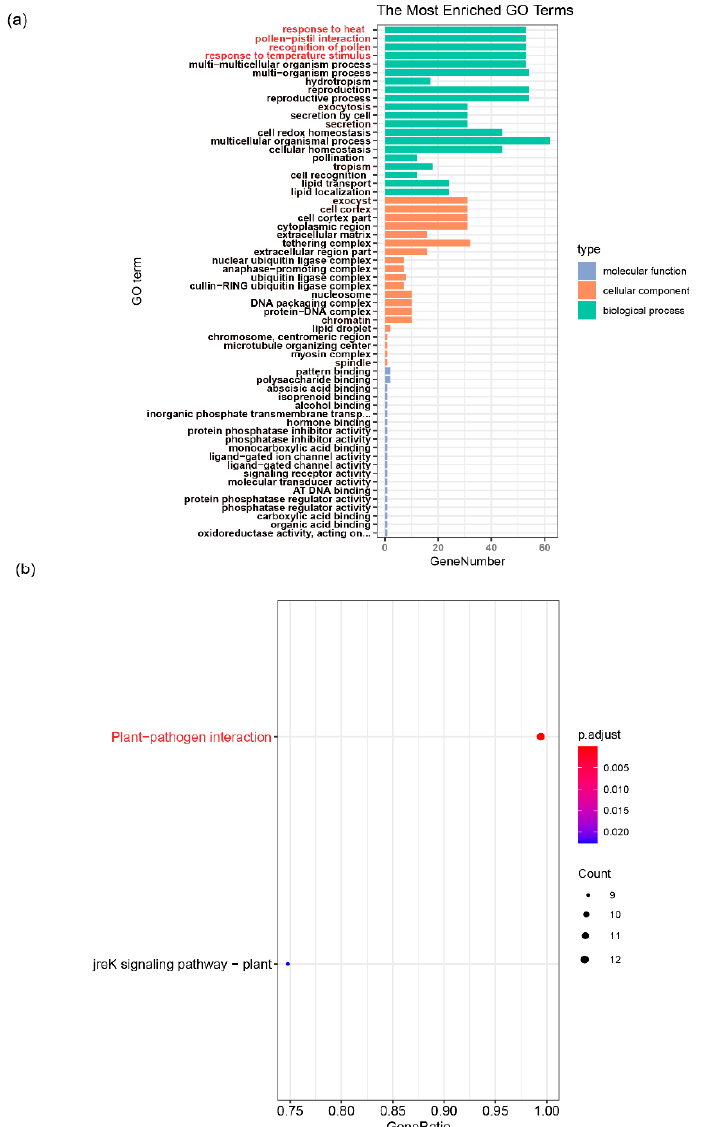
Figure 7. GO and KEGG enrichment analysis of WRKY gene family in walnut. ( a ) the GO enrichment analysis of WRKY genes in walnut. ( b ) the KEGG enrichment analysis of WRKY genes in walnut. The red marked indicates that the concerned terms in this study.